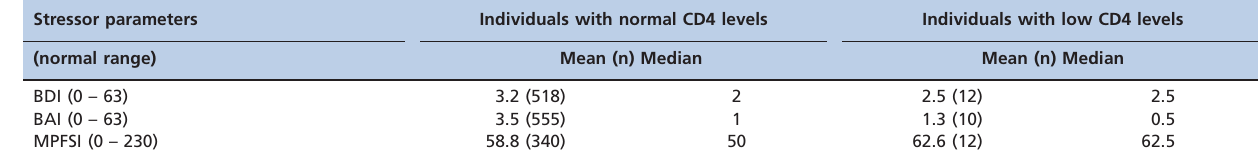
Table 3 - Psychosocial parameters and CD4 levels of the Brazilian Military Peace Force (n= 642), Contingent III. Stressor parameters